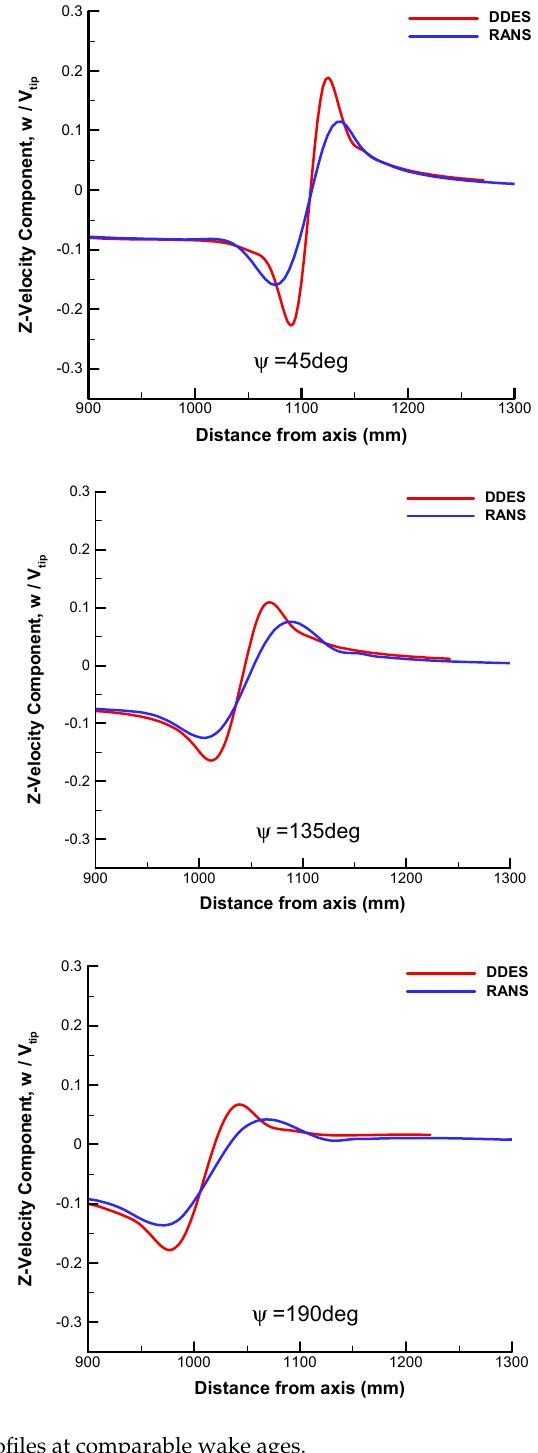
Figure 18. Comparisons of vortex core diameters at different wake ages between RANS and DDES. For the resolving of the spatial turbulence with the switch of LES mode, the major improvement of DDES compared with RANS is the resolution of primary structures in the transient flow field, including blades tip vortices and vortex sheet. The enhancement of wake ages in an averaged flow field is secondary.